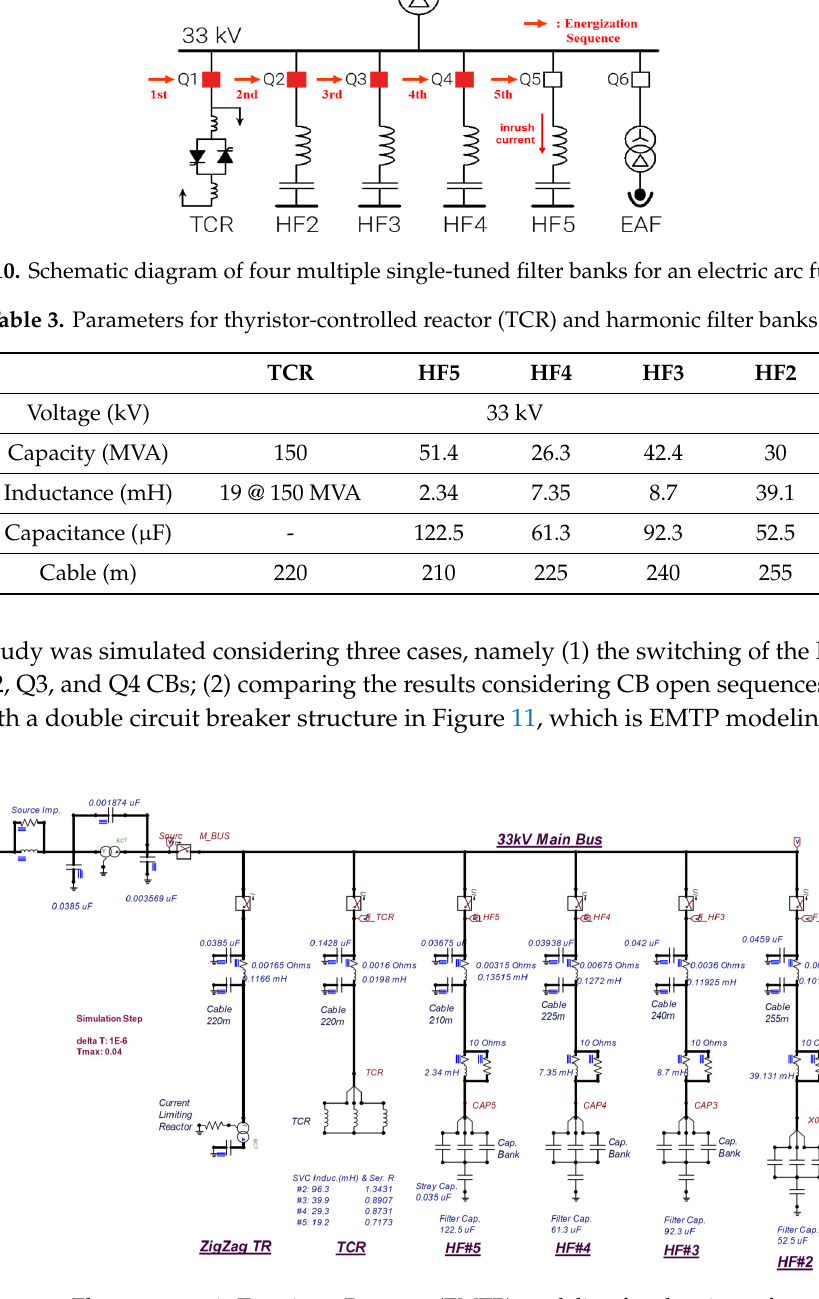
Figure 11. Electromagnetic Transients Program(EMTP)modelingfor electric arc furnace. Table 3. Parameters for thyristor-controlled reactor (TCR) and harmonic filter